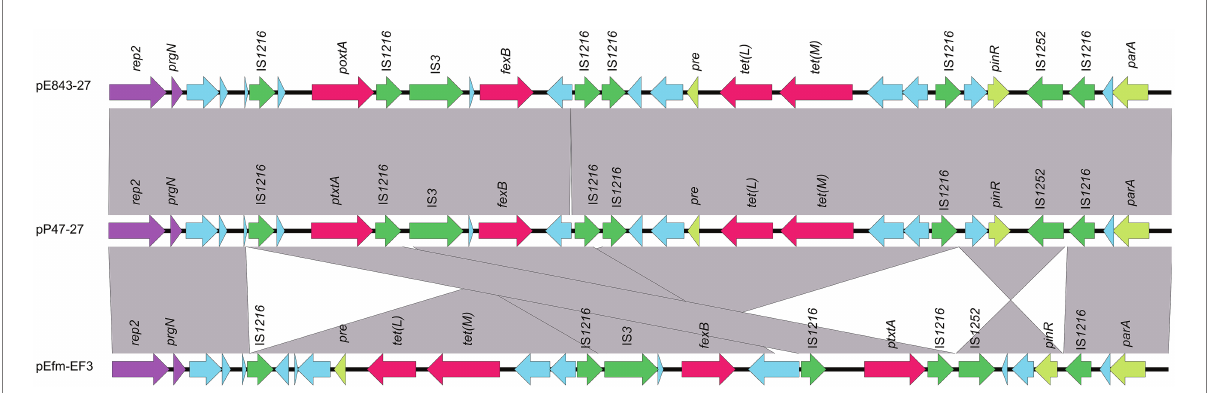
FIGURE 3 Genetic environments of the poxtA and fexB genes encoded in different plasmids. The ORFs are shown as arrows, and the arrowheads indicate the direction of transcription. The same color represents the same elements and genes, with antimicrobial resistance genes in red, mobile genetic elements in green, replications in purple, and other genes in blue. Gray-shaded areas represent regions with >95% nucleotide sequence identities. The sequences and their origins are Enterococcus lactis E843 (the plasmid of Enterococcus lactis E843 isolated from swine, CP082268.1) and Enterococcus faecium EF3 (the plasmid of Enterococcus faecium EF3 isolated from marine sediment,